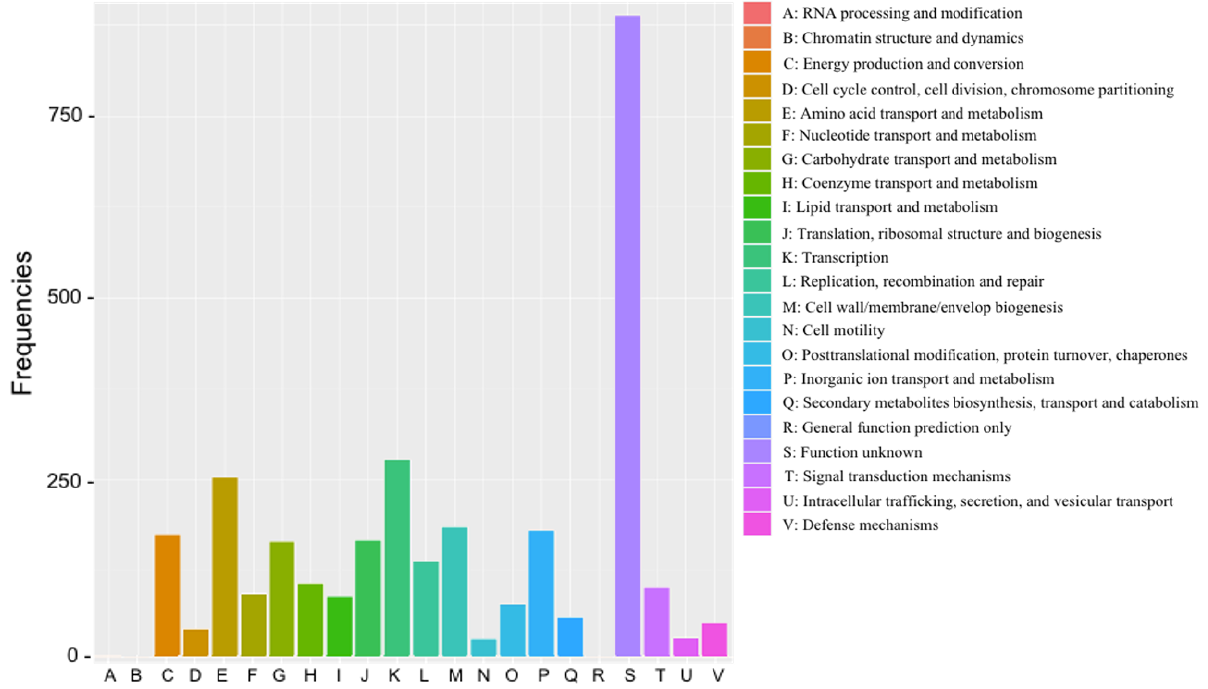
Figure 4. The cluster of orthologous group (COG) categories of the strain VTX20.